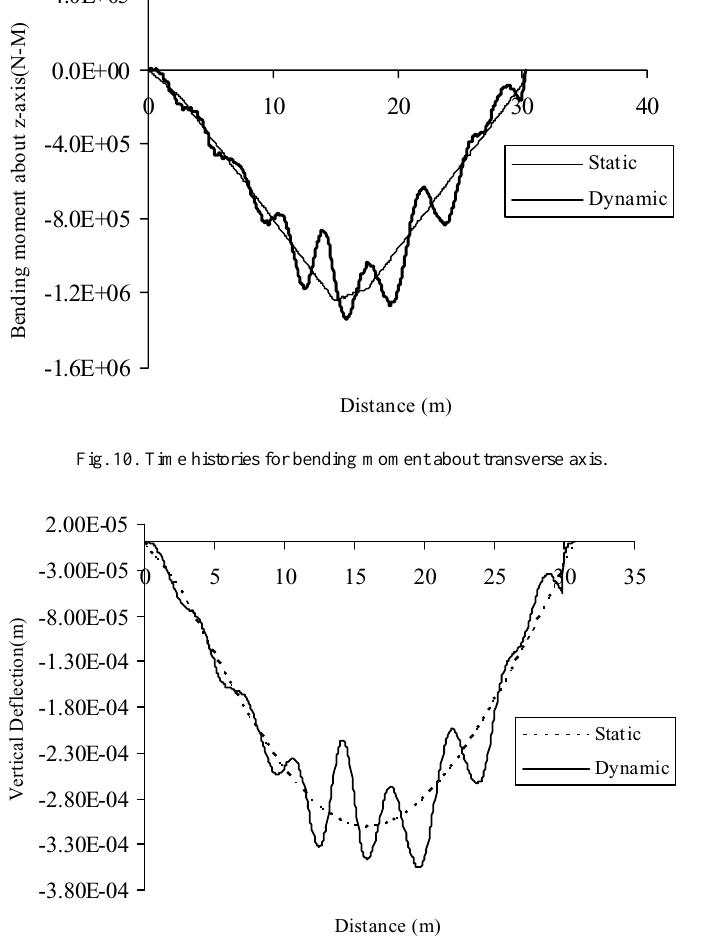
Fig. 11. Time histories for vertical